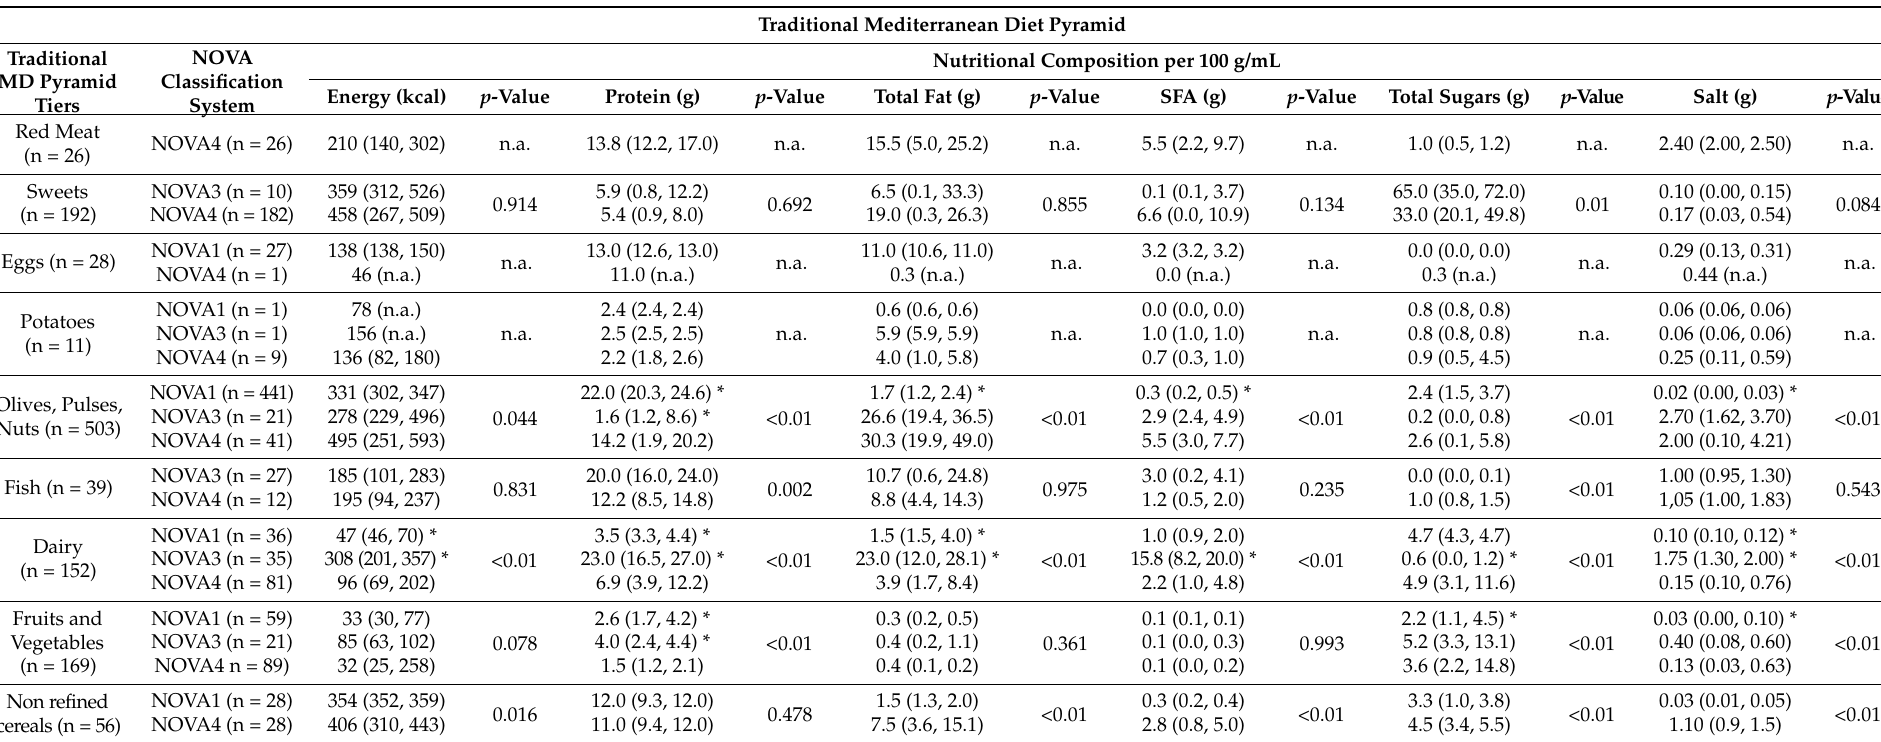
Table 4. Nutritional composition of foods that compose the traditional Mediterranean diet pyramid, per pyramid tier and per NOVA group. Traditional Mediterranean Diet